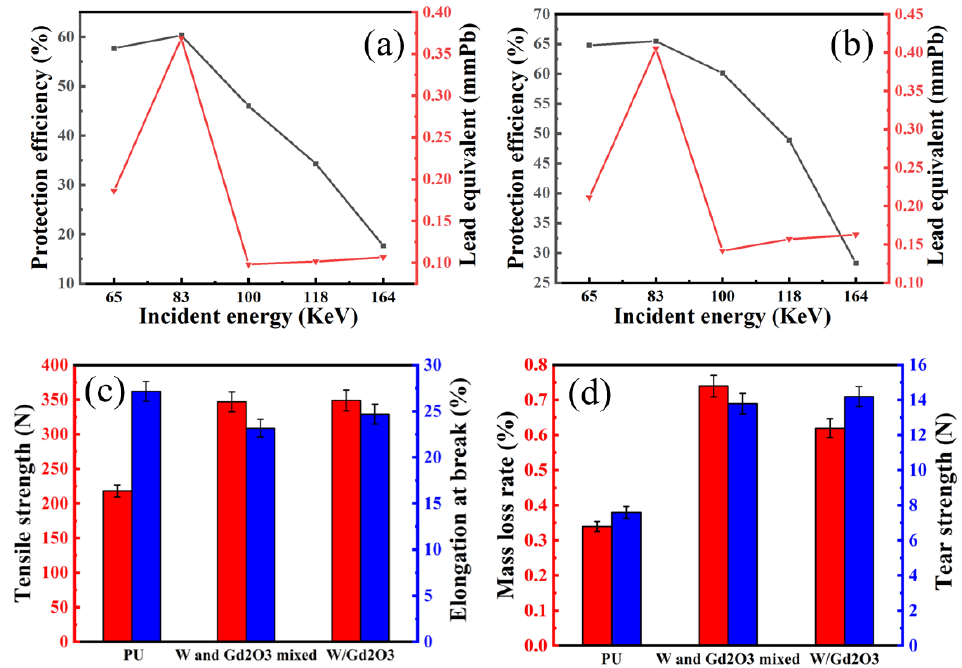
Figure 5. ( a ) Protective performance of PU coating fabric with W and Gd 2 O 3 mixed powder; ( b ) protective performance of PU coating fabric with core–shell structure W/Gd 2 O 3 powder; ( c ) tensile properties of pure PU coating fabric, W and Gd 2 O 3 mixed powder PU coating fabric, and core–shell structure W/Gd 2 O 3 powder PU coating fabric; ( d ) Wear resistance and tearing properties of pure PU coating fabric, W and Gd 2 O 3 mixed powder PU coating fabric and core–shell structure W/Gd 2 O 3 powder PU coating fabric.